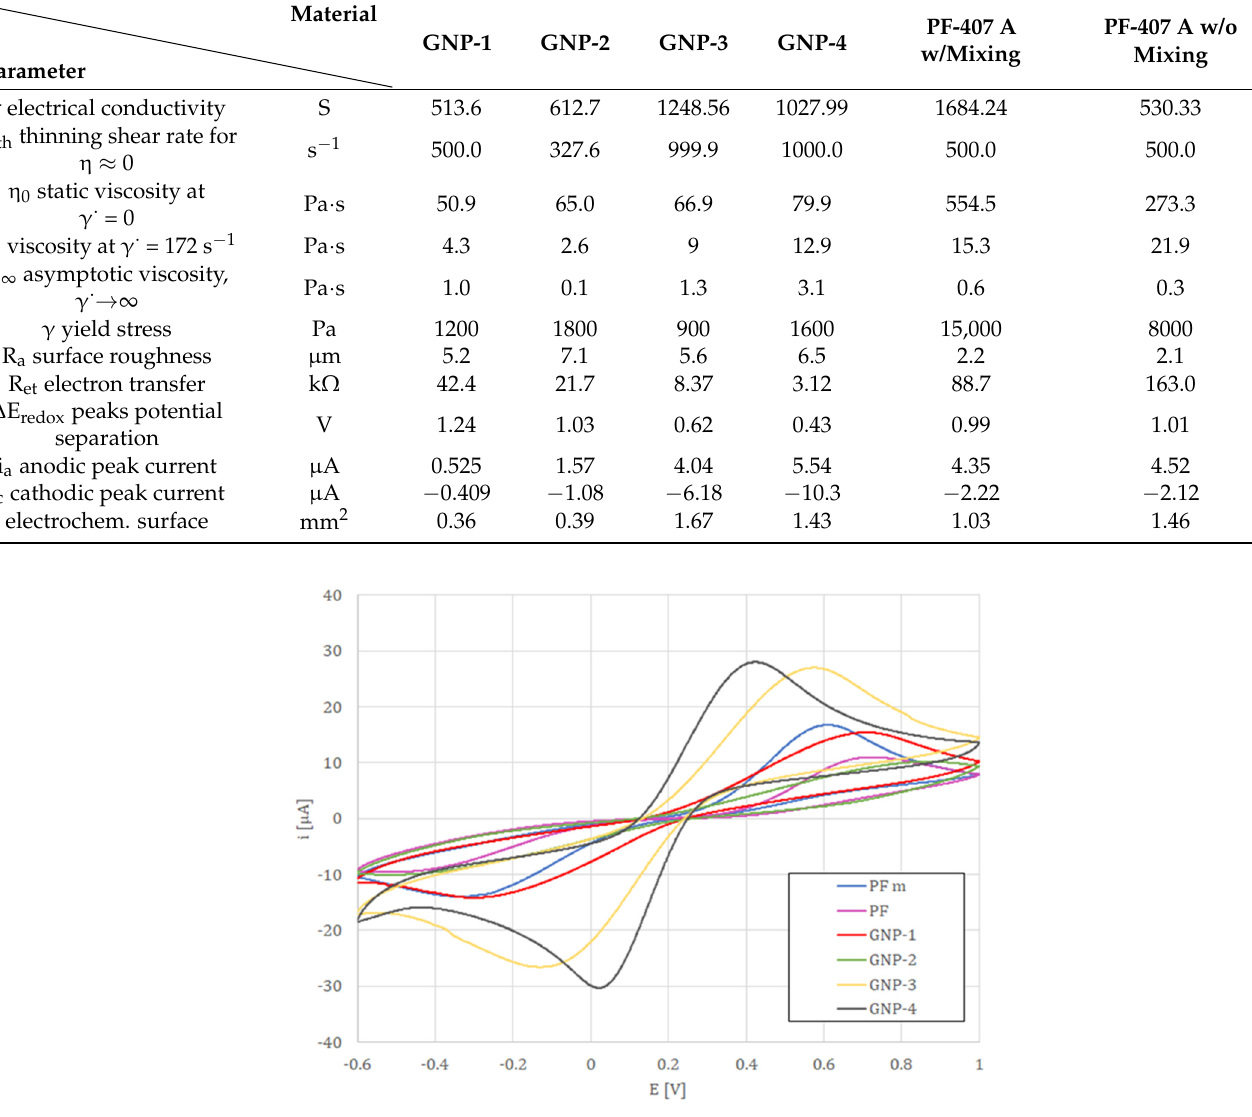
Figure 2. CV measurements of SPEs fabricated with the examined pastes vs. Ag/AgCl/1.0 mol L − 1 KCL reference electrode and a gold wire as the auxiliary electrode in 5 mM ferri/ferrocyanide in 0.1 M KCl solution; scan rate of 0.1 Vs − 1